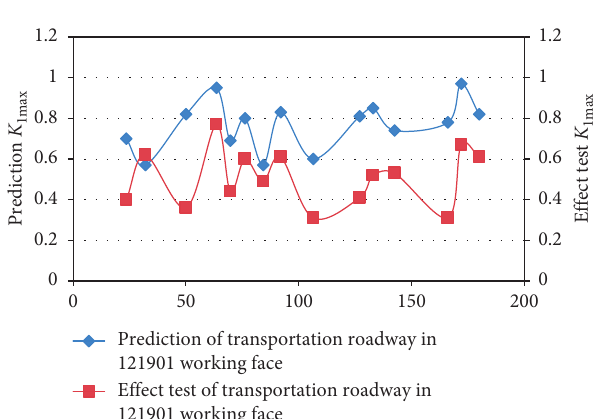
Figure 2: Changes of the index of S preventative measures in the transportation roadway in the 121901 working